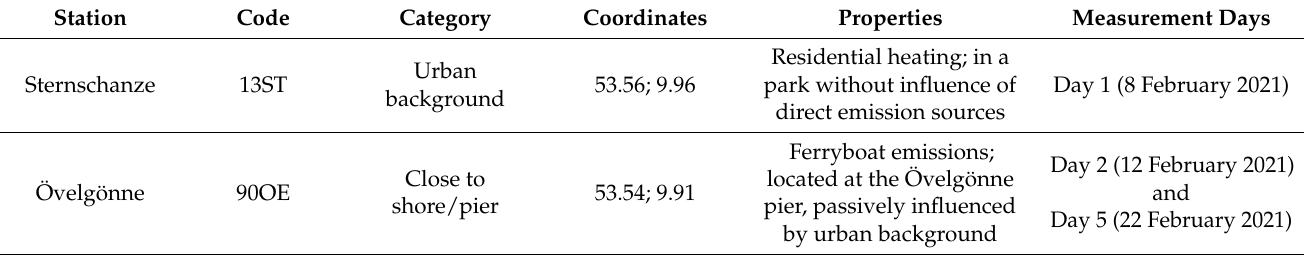
Table A1. List of the monitoring stations of the HaLM network and the measurement sites considered in this study, including information on station category, station location (coordinates in decimal degrees) and a short description of the station. The date of the measurement is given for the stations where measurements of PN concentrations took place.